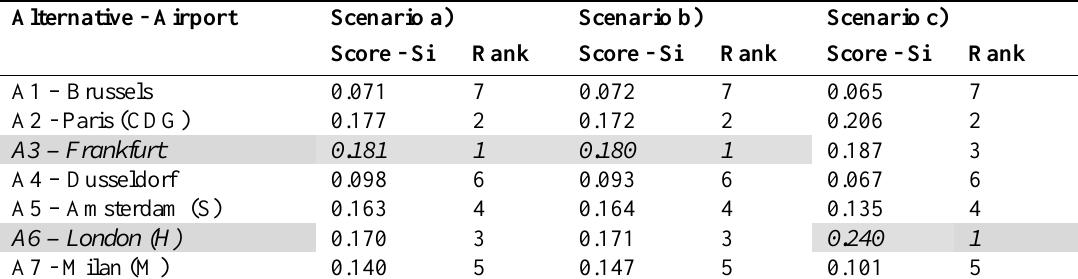
Table 5. The AHP ranking of alternatives in a given example